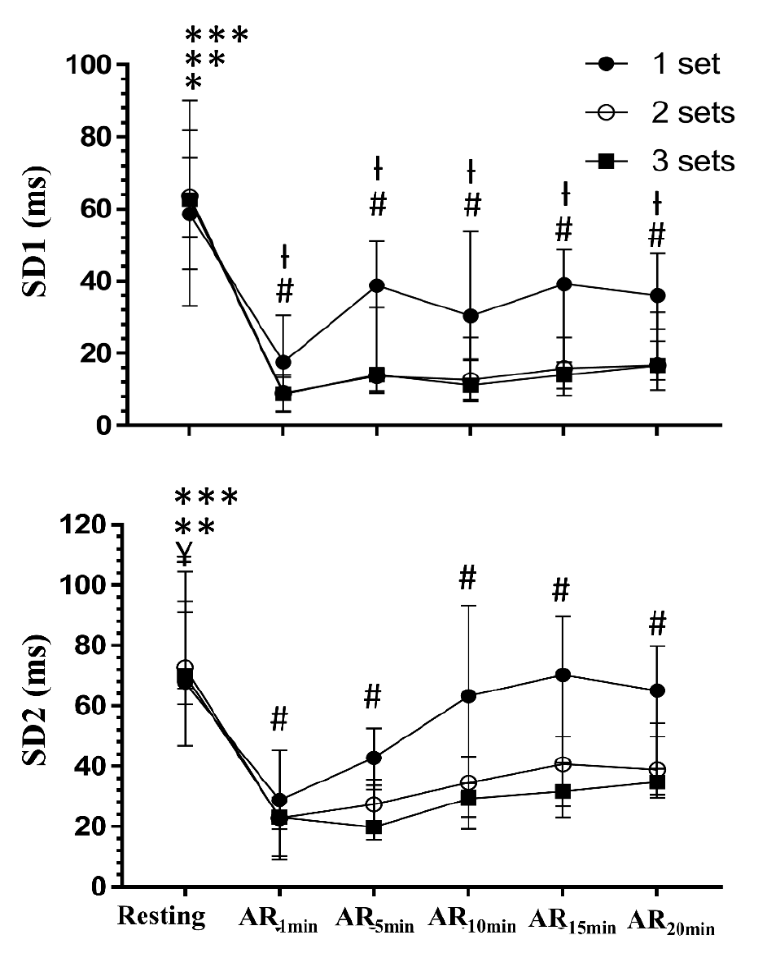
Figure 1- Median and interquartile range of cardiac parasympathetic (SD1) and global (SD2) modulation in resting supine position (Resting) and during 1st (AR1min), 5th (AR5min), 10th (AR10min), 15th (AR15), and 20th (AR20min) minutes of postexercise recovery phases. #Significant difference compared to 3 sets (Friedman test, p < 0.05); Ɨ Significant difference compared to 2 sets (Friedman test, p < 0.05); *Significant difference between resting 1-set protocol and all intragroup postexercise analysis (Wilcoxon test, p < 0.05); **Significant difference between resting 2-set protocol and all intragroup postexercise analysis (Wilcoxon test, p < 0.05);